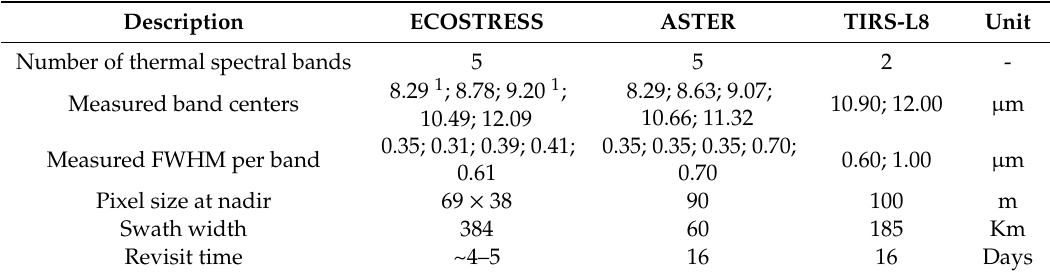
Table 1. Sensor technical characteristics and thermal bands used for this work. 1 Bands not available after 15 May, 2019. ECOSTRESS: ECO System Spaceborne Thermal Radiometer Experiment on Space Station; ASTER: Advanced Spaceborne Thermal Emission and Reflectance radiometer; TIRS: Thermal Infrared Sensor; FWHM: Full Width at Half Maximum. Description ECOSTRESS ASTER TIRS-L8 Unit Number of thermal spectral bands Measured band